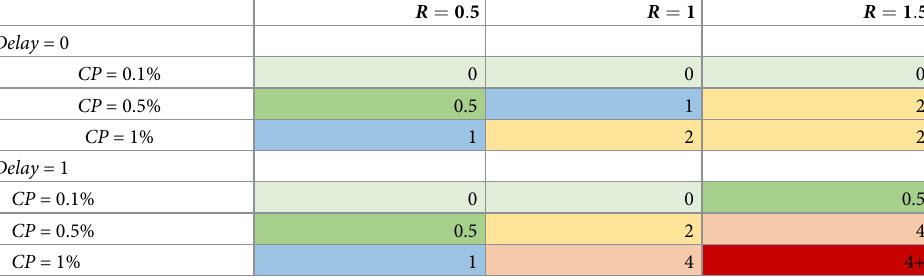
Table 2. Test frequency to prevent excessive infections. Test frequency (tests per week) under a systematic testing strategy needed to maintain the upper quartile of expected infections in the simulated facility below a threshold of 1 every ten days across transmission scenarios conveyed by the within-facility basic reproduction number ( R ), commu- nity prevalence (CP), and delays between testing and isolation of infectious workers. R ¼ 0 : 5